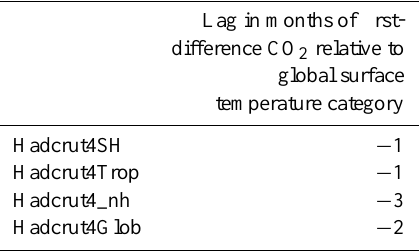
Table 1. Lag of first-difference CO 2 relative to surface tempera- ture series for global, tropical, Northern Hemisphere and Southern Hemisphere categories.